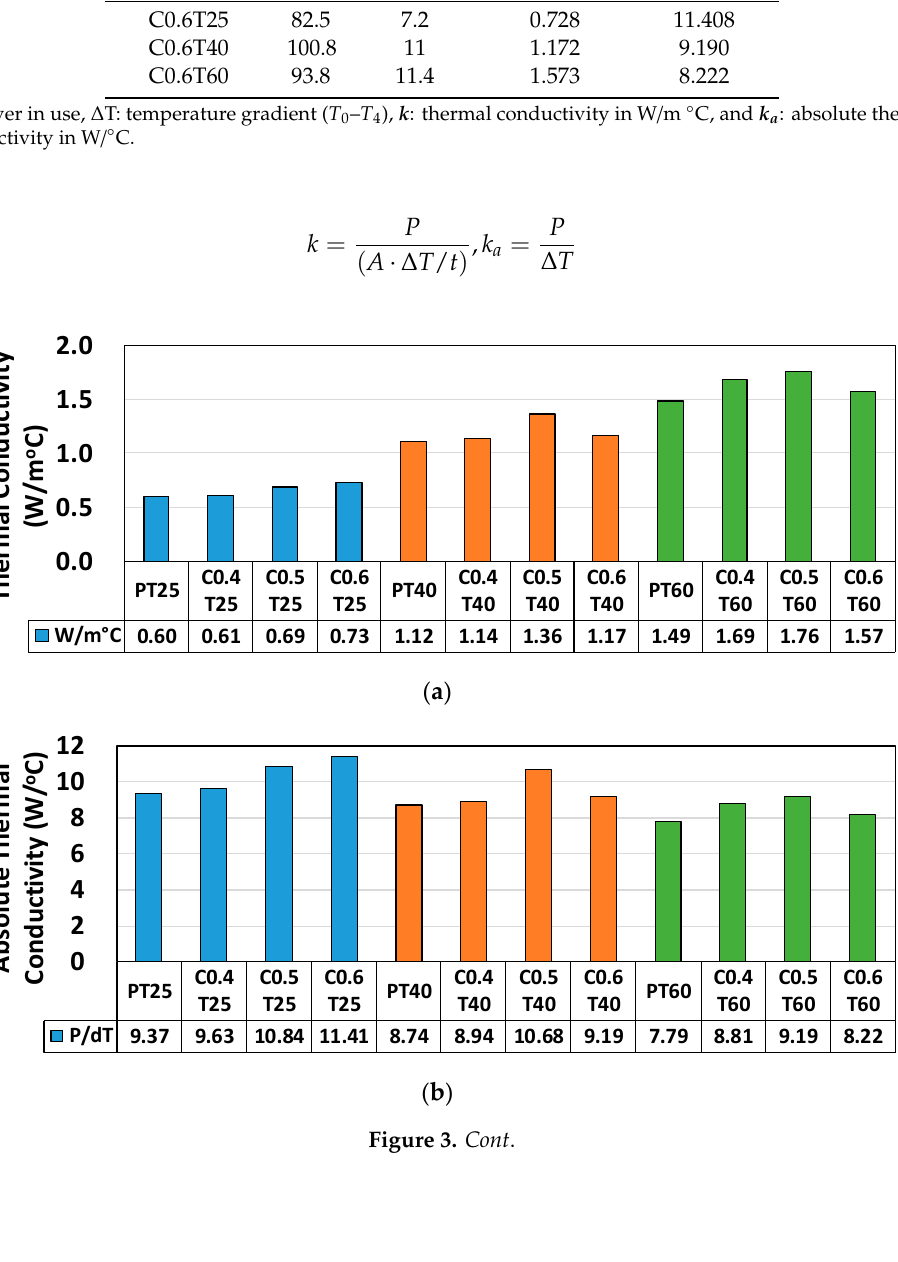
Table 3. Thermal conductivities of test specimens by average power and temperature gradient. Specimen